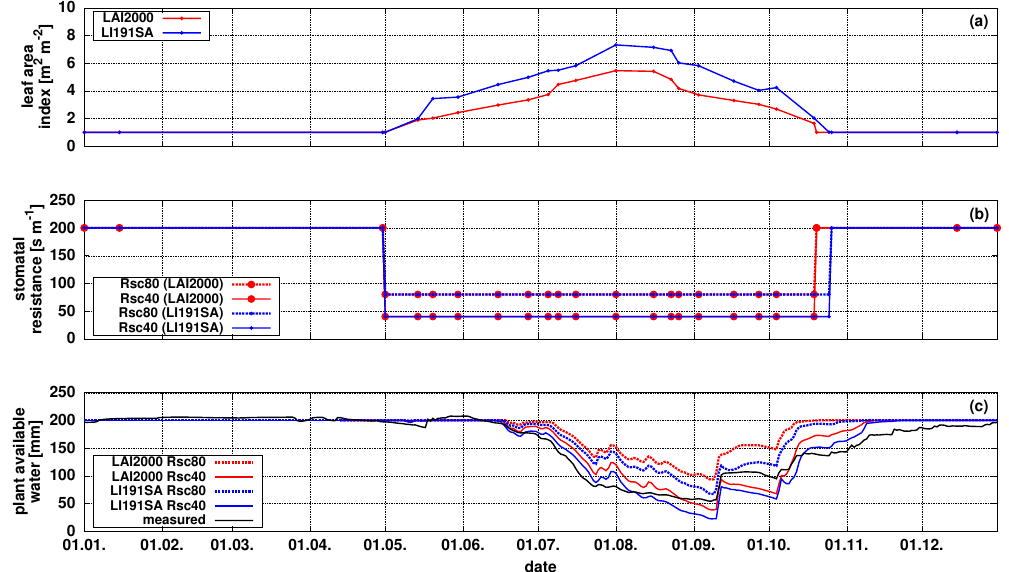
Figure 4. Leaf area index and stomatal resistance as parameterised from measurements. Leaf area index is used as measured, LAI2000 (red) and LI191SA (blue). Stomatal resistance is set to the measured minimum, i.e. 80sm − 1 (dashed line) and to 40sm − 1 (solid line) as leaf area index is larger than 1. Length of growing season is determined by the leaf area observations. Simulation results using the four combinations of leaf area index and stomatal resistance are shown as plant available soil water, calculated until 1m soil depth and compared to values based on soil water content